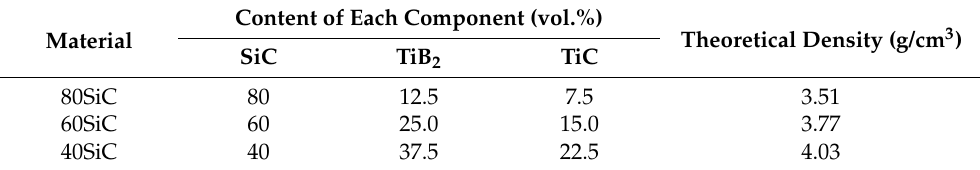
Table 3. Composition of ceramic